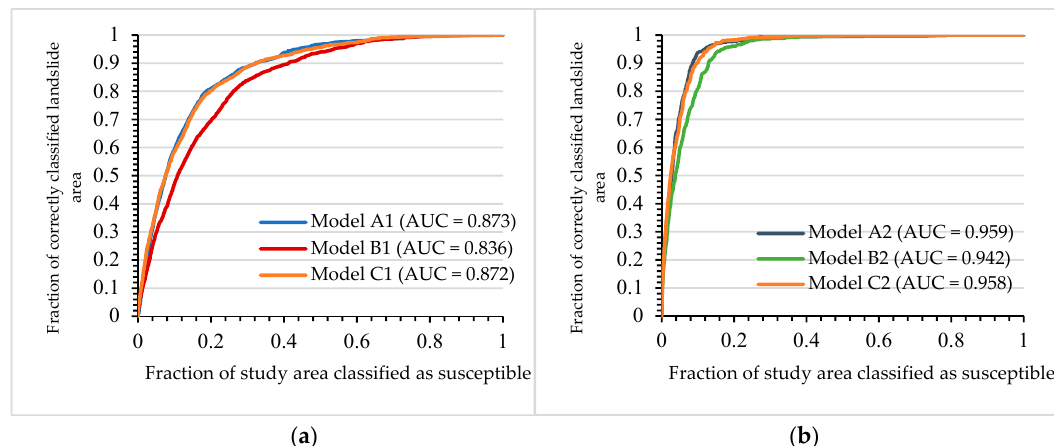
Figure 15. Success rate curves for landslide susceptibility models built with rainfall-triggered landslides ( a ) and earthquake-triggered landslides ( b ).